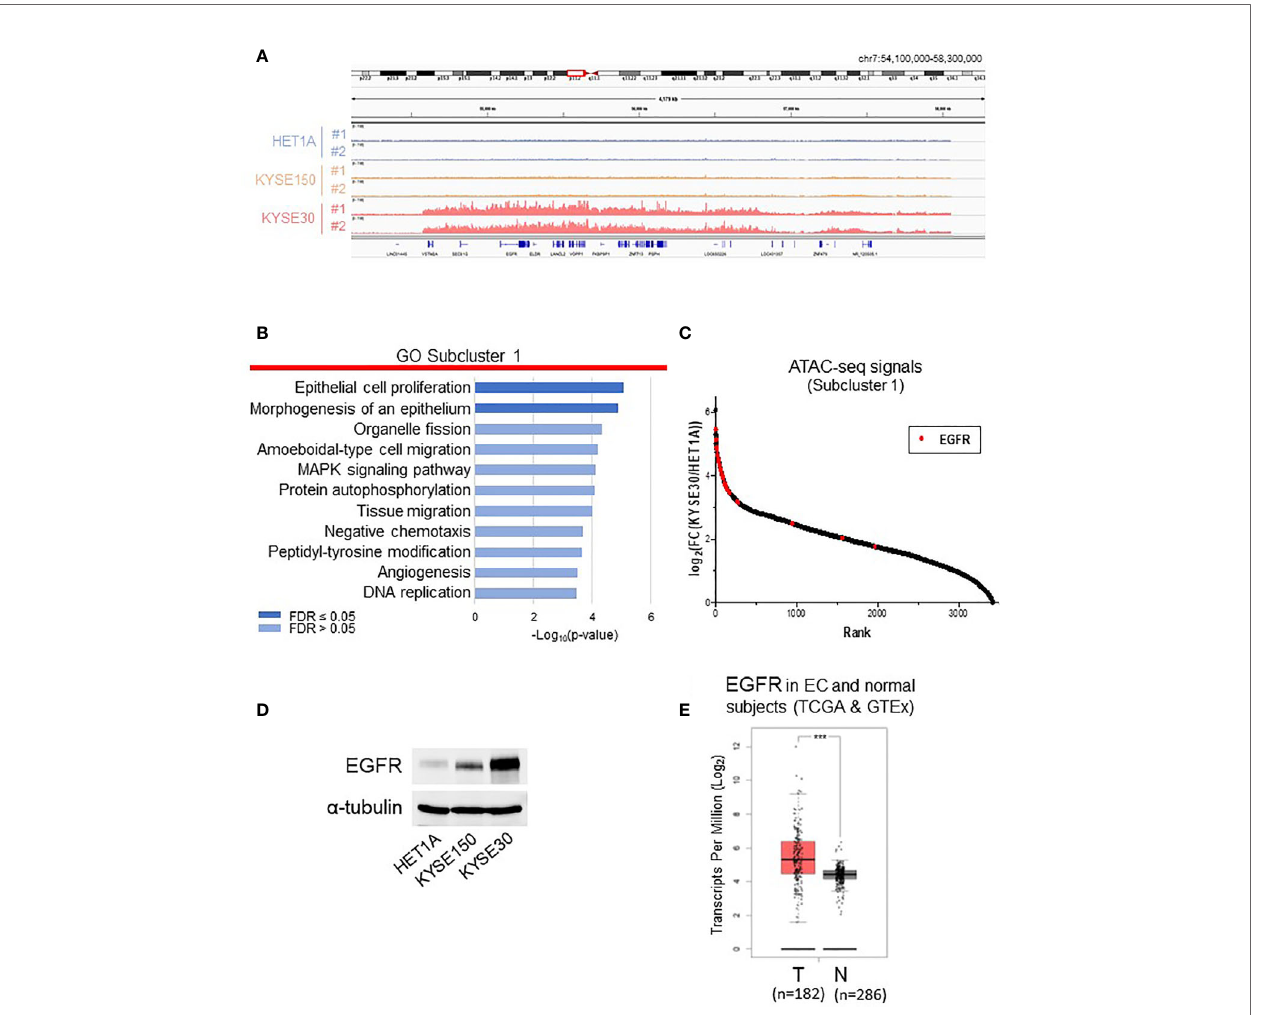
FIGURE 2 | Analyses of subcluster 1 that includes highly accessible chromatin regions in KYSE-30 cells. (A) Exemplary ATAC-seq peaks on chromosome 7 showed that these regions are hyper-accessible in KYSE-30 cells. (B) Differentially accessible regions in subcluster 1 were associated to the nearest genes, and functional enrichment analysis of this gene set shows various cell signaling pathways associated with cancer. (C) In subcluster 1 ATAC-seq peak set ( n = 3445 peaks), the fold changes of peak frequencies in KYSE-30 versus HET-1A cells were calculated and ranked. The highest number of differential ATAC-seq peaks were found near the EGFR gene, and most of these peaks (28/31) were ranked within the top 10%. Red marks indicate the fold change of each EGFR-associated ATAC-seq peak ( n = 31). (D) Representative Western blot showed that EGFR expression was upregulated in KYSE-150 and KYSE-30 cells. (E) EGFR gene had higher expression in tumors (T) than in neighboring tissues of esophageal cancer patients (TCGA data) or normal esophagus (GTEx data) (N). T = 182, N = 286; Log2FC >0.5; *** p -value <